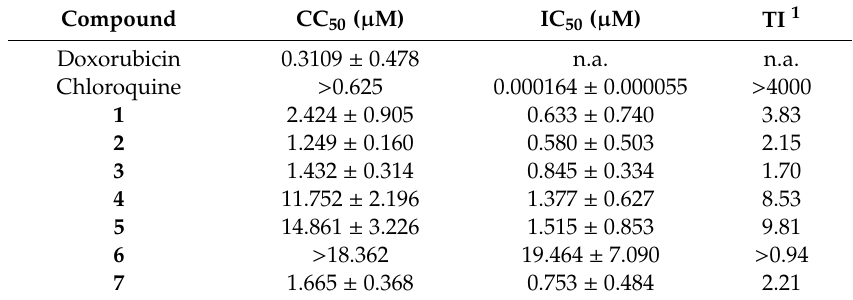
Table 2. In vitro cytotoxic and antiplasmodial activities of dunnione derivatives (DUNs) on Hela cells and a Plasmodium falciparum FcB1 clone, respectively.